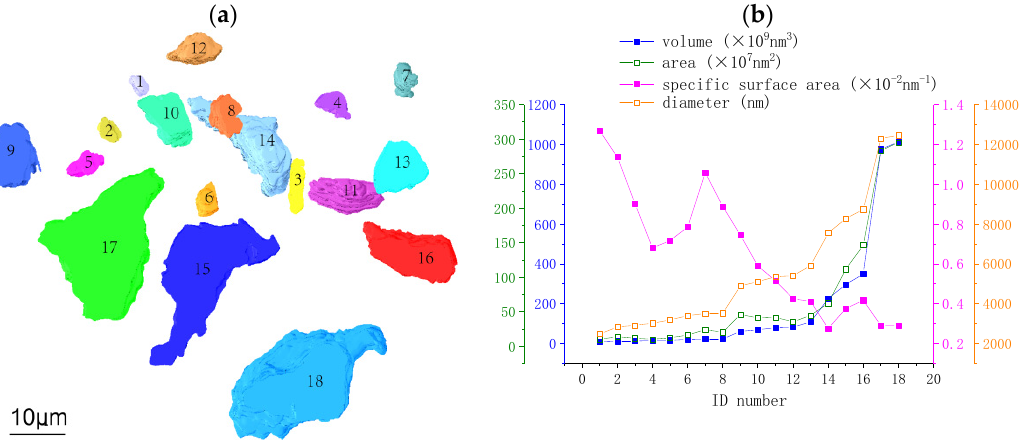
Figure 2. 3D image and quantitative analysis of anhydrous particles: ( a ) labeled 3D images of anhydrous particles and ( b ) the volume, area, specific surface area and diameter analysis of anhydrous C 3 S particles.